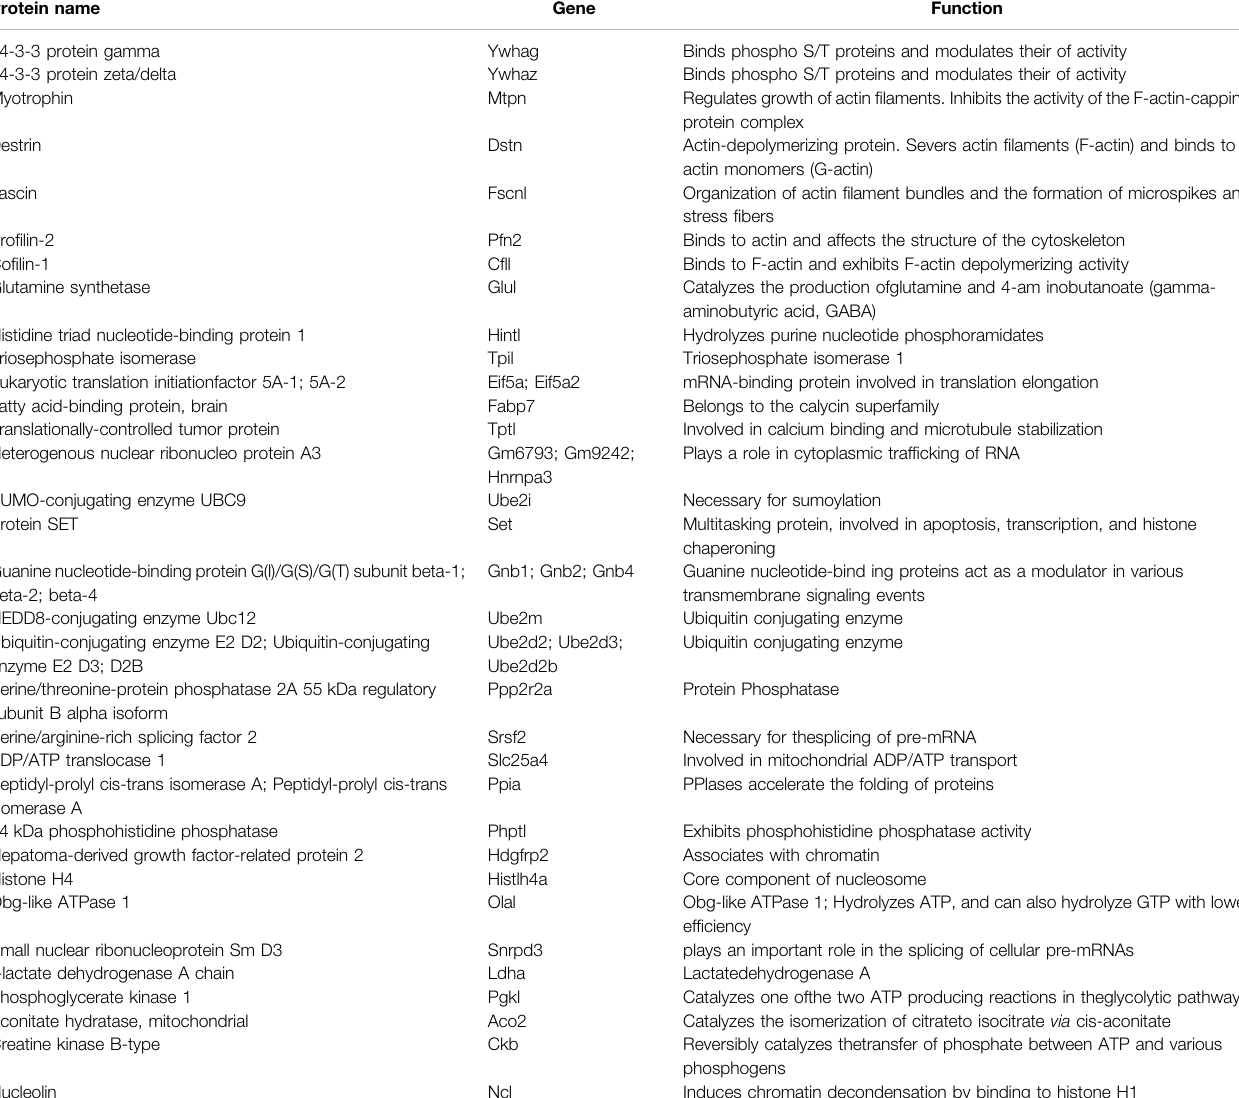
TABLE 1 | List of proteins identi fi ed by Mass Spectrometry that associate with Septin 7 when phosphorylated at residue T426. Protein